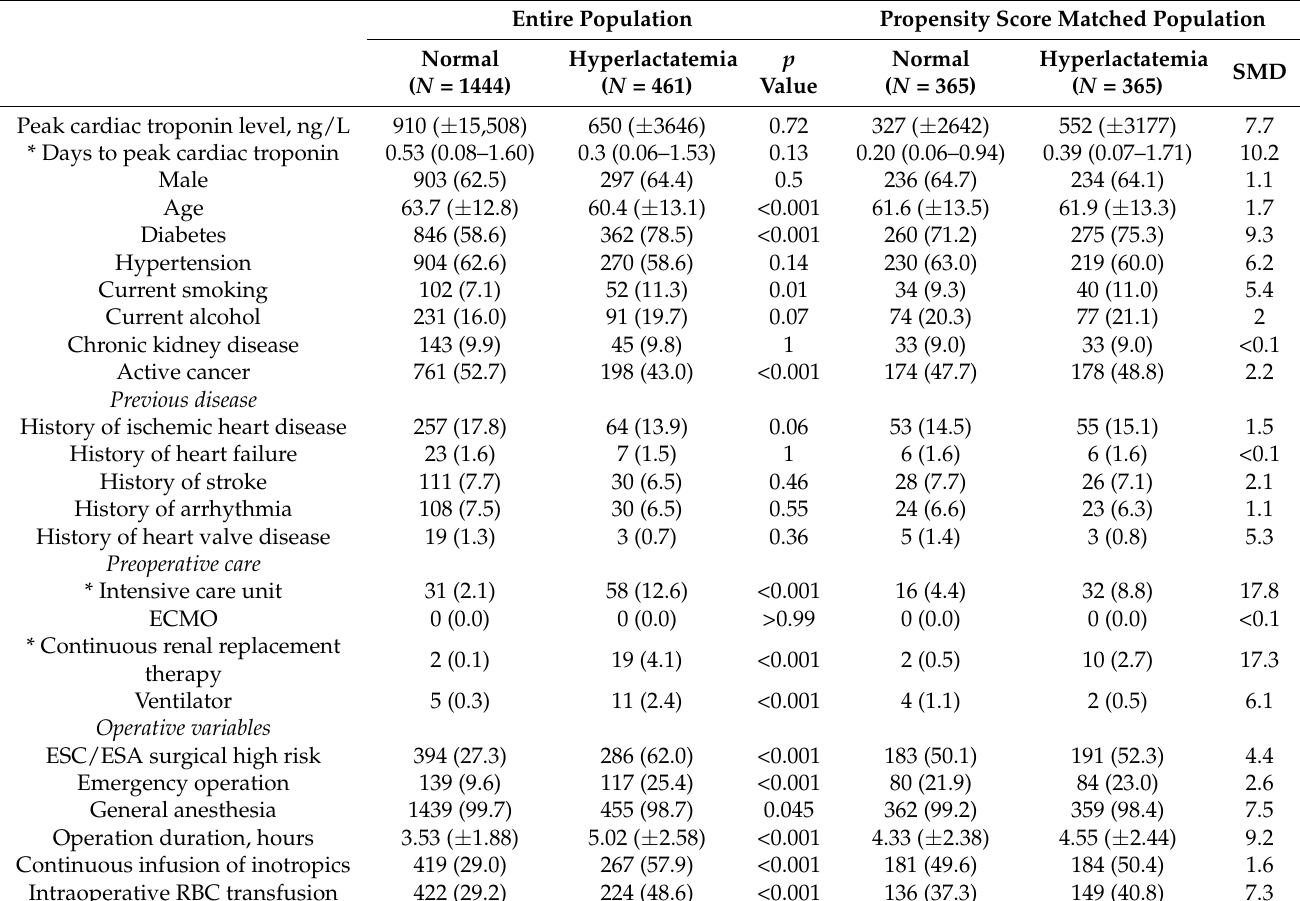
Table 1. Baseline characteristics of the entire population according to intraoperative hyperlactatemia.